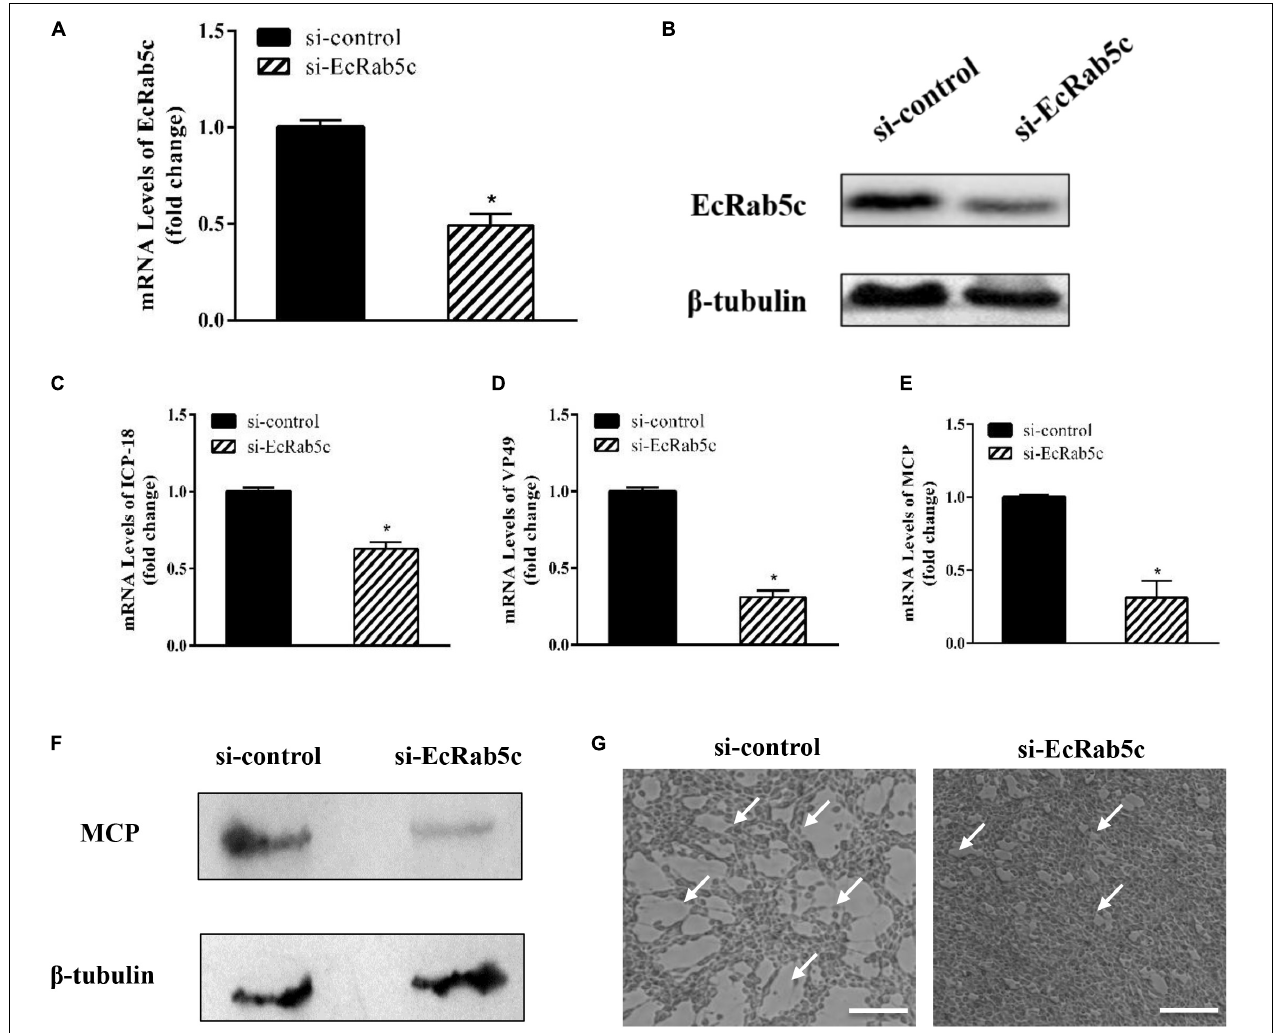
FIGURE 2 | The si-EcRab5c significantly inhibited SGIV replication. (A,B) The knockdown efficiency of si-EcRab5c. GS cells were transfected with si-control or si-EcRab5c. After 36 h, the cells were harvested for qRT-PCR (A) and Western blotting (B) . β -tubulin was used as the internal control. (C–E) Knockdown of EcRab5c suppressed the expression of SGIV genes. GS cells were transfected with si-control or si-EcRab5c, incubated with SGIV at 12 h post transfection, and then collected at 24 hpi for further qRT-PCR analysis. Viral ICP-18 (C) , VP49 (D) , and MCP (E) were analyzed by qRT-PCR. The data were shown as fold change and indicated as the mean ± SEM ( n = 3). Statistic differences are shown as * p < 0.05. (F) Knockdown of EcRab5c inhibited the protein expression of SGIV MCP. (G) Knockdown of EcRab5c reduced the CPE induced by SGIV. The arrows show the CPE. Scale bars represent 100 µ m.